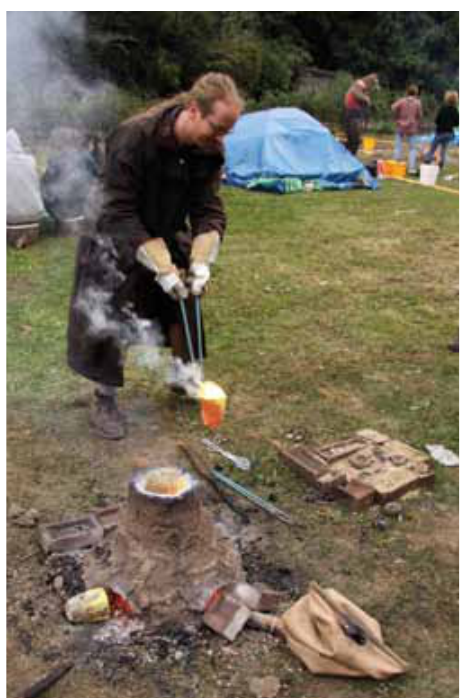
Fig. 1: Smelting metal on the Experimental Archaeology